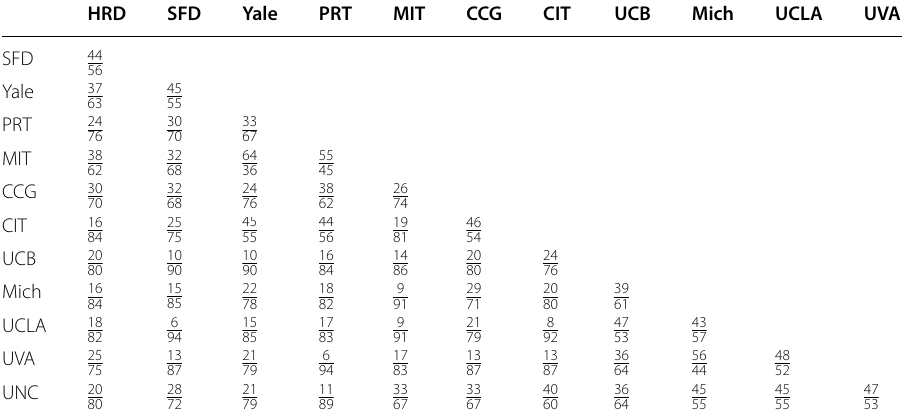
Table 3 Sample revealed preference represented as odds ratios. Source: www.parch